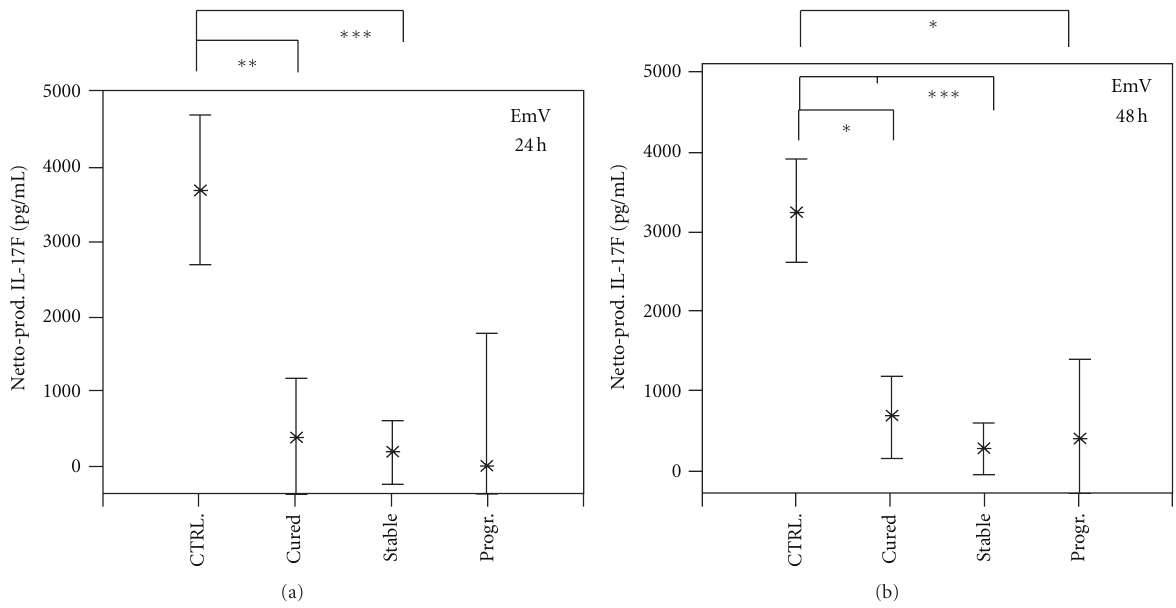
Figure 5: Echinococcus multilocularis antigen- (EmAg-) induced cellular production of interleukin-17F (IL-17F) by PBMC from Alveolar Echinococcosis (AE) patients and infection-free controls (CTRL). Patients were grouped according to their state of infection, that is, cured, stable, or progressive (Prog.) Alveolar Echinococcosis. PBMC from patients and controls were stimulated with E. multilocularis vesicle extract (EmV) for 24 (part a) and 48 hours (part b) or left unstimulated. Cytokine concentrations in cell culture supernatant were determined by specific ELISA. The EmAg-induced cytokine production (Netto Prod.) was calculated by subtracting the cytokine production in not stimulated PBMC cultures (baseline) from EmV-stimulated cytokine production (Brutto production). The cytokine production is shown as mean values in pg/mL with the 95% upper and lower confidence interval. The level of significance was adjusted by the Bonferroni-Holm method. The significant di ff erences between groups are indicated ( ∗ P < 0 . 05, ∗∗ P < 0 . 01, and ∗∗∗ P < 0 .